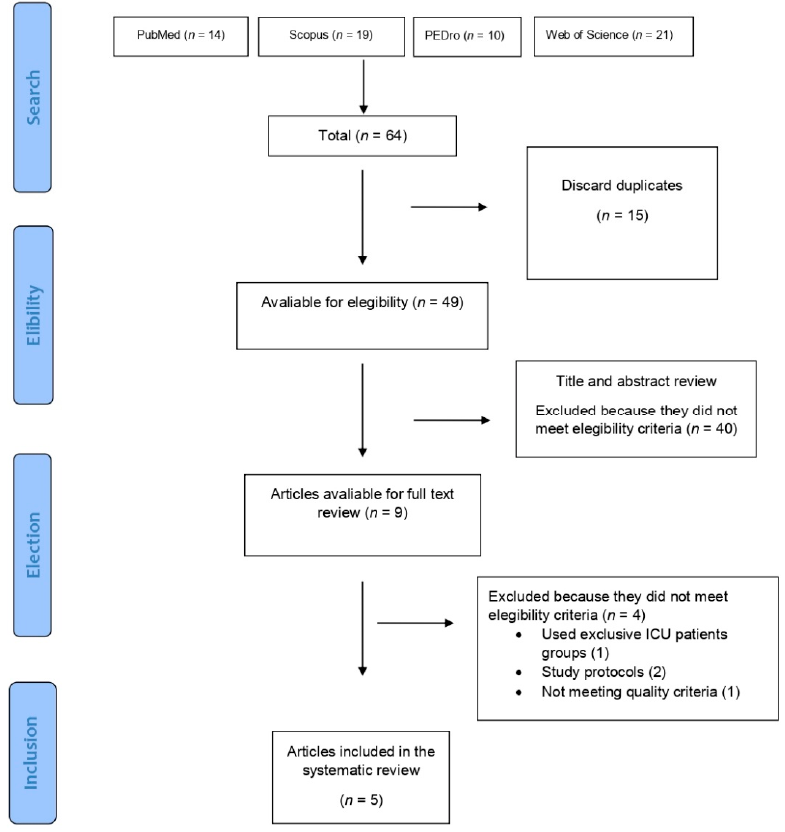
Figure 1. Flow chart diagram.